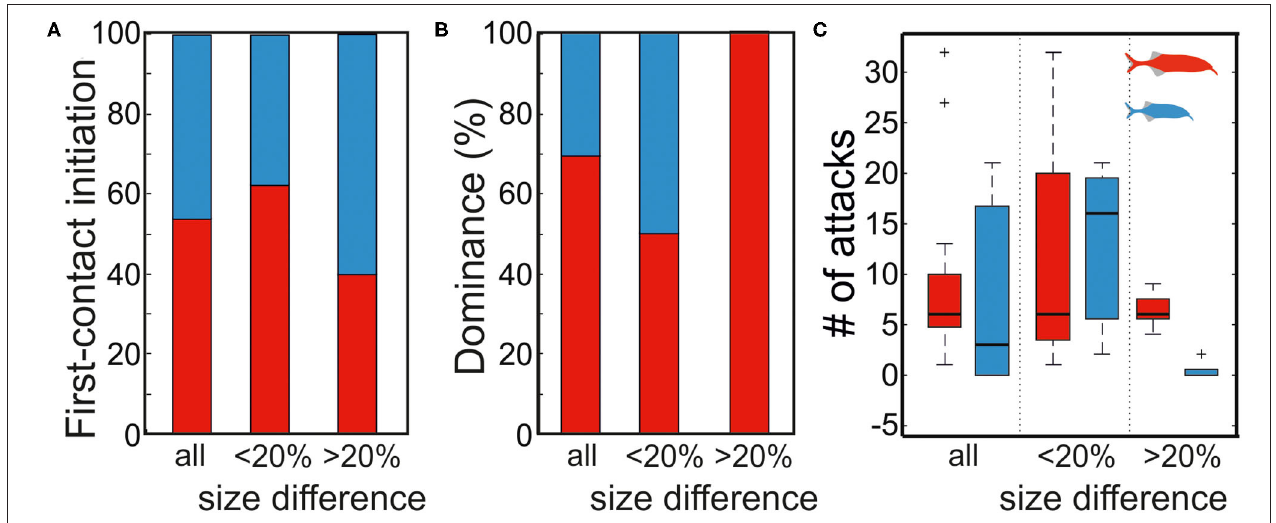
FIGURE 8 | Effect of fish size on first contact initiation and dominance status. (A) The first contact was initiate independent of fish size (binomial test, p = 0.5, 0.5, and 0.36 for all, > 20%, and < 20% size differences, respectively). (B) The dominance status dependent on fish size for size differences > 20% (binomial test, p = 0.031). No difference in dominance was found for small size differences (binomial test, p = 0.636). (C) Aggression level also was dependent on size difference. Big fish attacked significantly more during dyadic interactions of large size differences while more aggressive behaviors (number of attacks) were found in an interaction among fish of small size differences. Red and blue symbols represent the large and small fish,